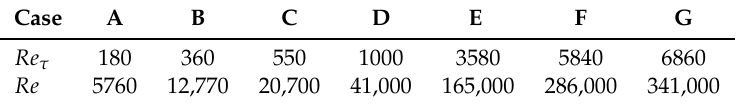
Table 6. Cylindrical pipe tests. Summary table and labels for different simulated